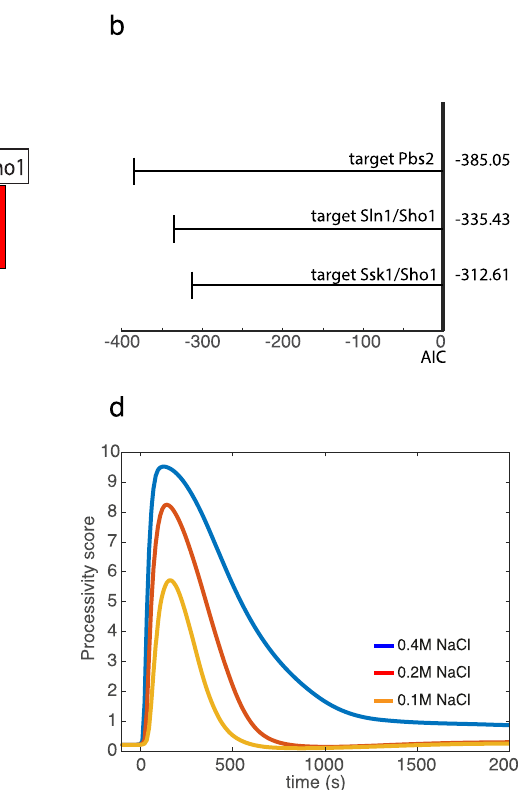
increase of the kinetic rate constant for the activation of Hog1 (catalytic feedback) andanincreaseintheassociationofHog1toPbs2(af fi nityfeedback). d Timecourse uponsaltstimulationshowingaprocessivityscorethatquanti fi estheratiobetween therateofthesecondHog1phosphorylationstepand itsdissociationfromPbs2.A low processivity score indicates distributive-like phosphorylation, while a high processivityscoreindicatesaprocessive-like mechanism.Notethatbefore starting the reaction the processivity score is low, but the onset of Hog1 signaling intro- ducespositivefeedback( t =0),whichincreasesthescoreuntilthereactionbehaves like a processive